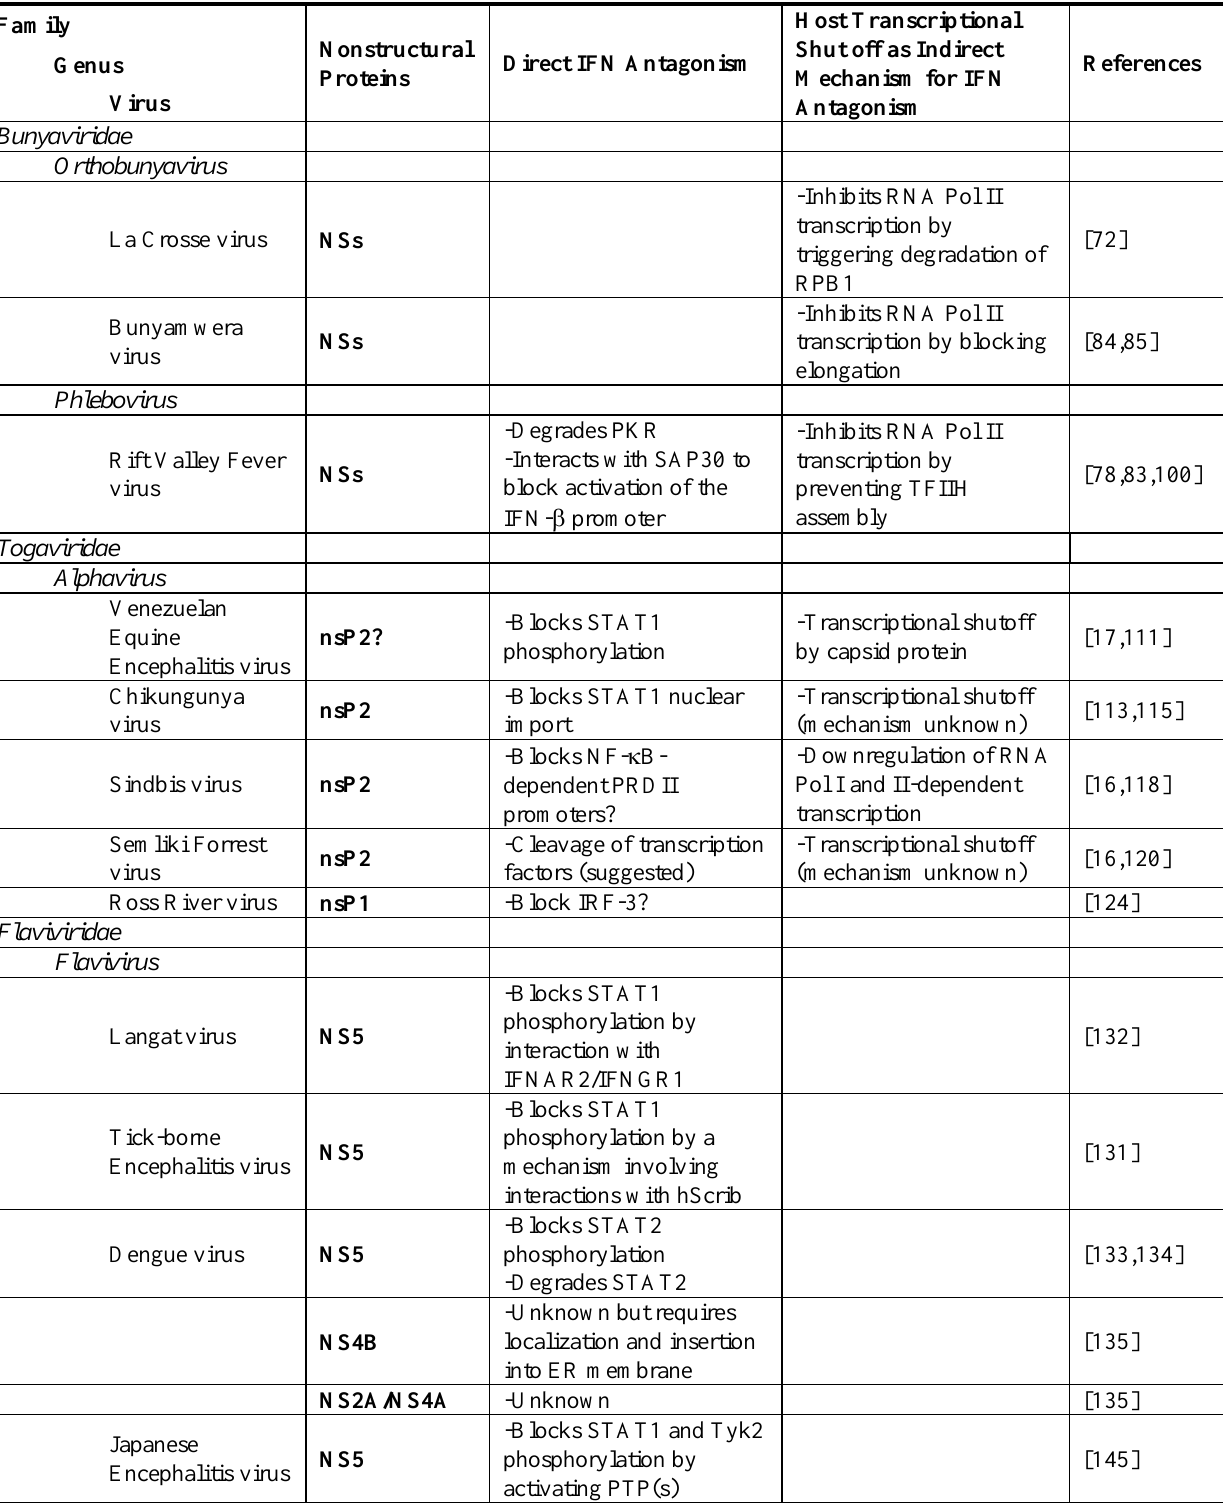
Table 1. Direct and indirect interferon antagonist functions of arboviral nonstructural